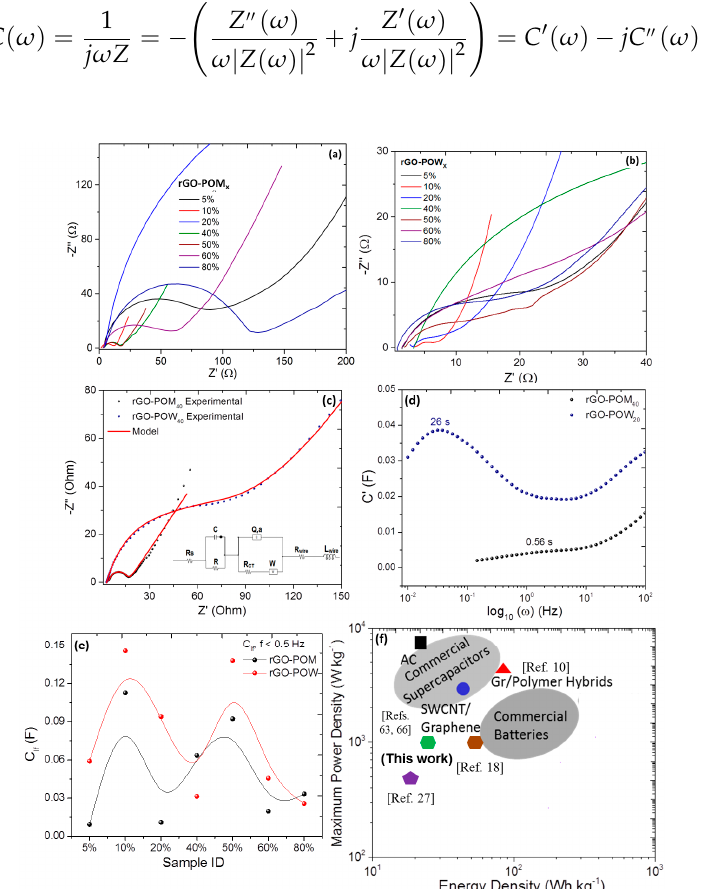
Figure 4. ( a , b ) Nyquist plots revealing capacitive behavior for grapheme-based hybrids at V = +0.3 V; ( c ) low frequency capacitance ( C lf ; F); ( d ) representative Nyquist plots modeling for rGO–POM 40 (and rGO-POW 40 ); ( e ) C ′ ( ω ) versus log of frequency behavior; and ( f ) the electrode performance i.e., Ragone plot for AC, CNT/graphene, commercial supercapacitors and batteries, graphene–polymer hybrids and graphene–polyoxometalates electrodes (this work). The inset (panel c) shows equivalent circuit used to fit the impedance